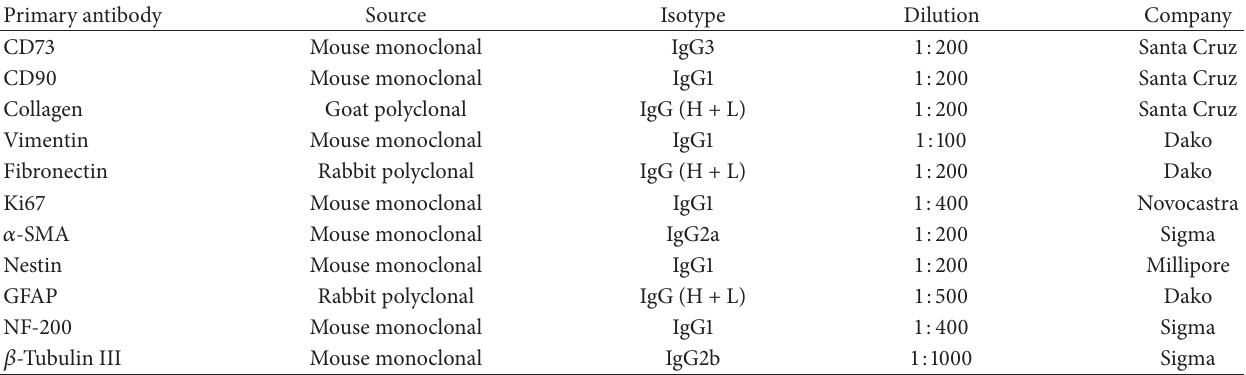
Table 1: Primary antibodies used for